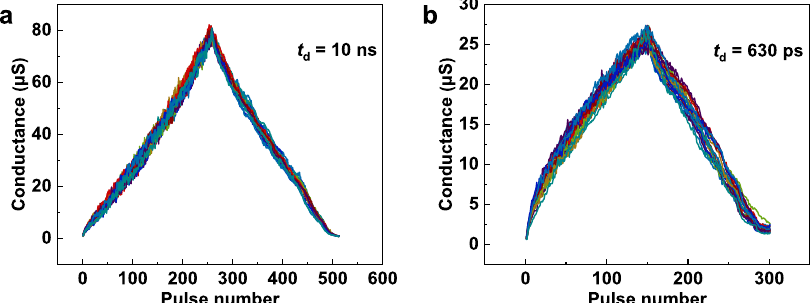
Fig. 6 Arti fi cial synapse analog based on the FTJ with a (111)-oriented PZT. a , b Potentiation and depression processes measured for 20 times from one FTJ sample with pulse durations of t d = 10 ns and t d = 630 ps,